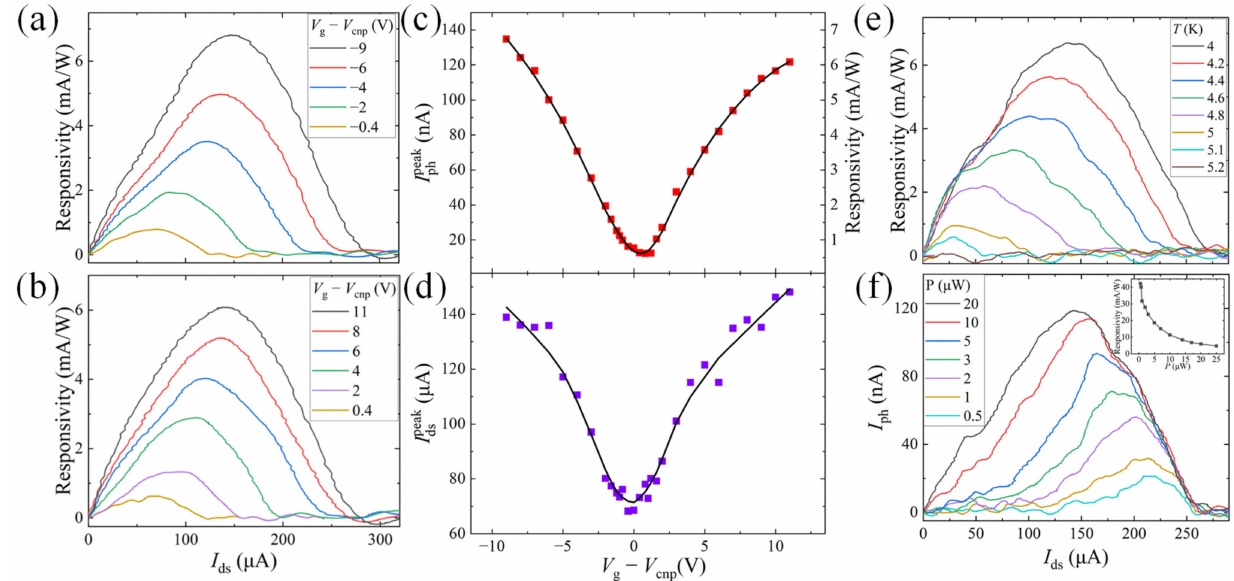
Figure 3. Modulation of the photoresponse in the superconducting NbSe 2 -MLG heterostructure. ( a , b ) Photoresponsivity as a function of the bias current at selected top gate voltages for p -doped ( a ) and n -doped graphene ( b ), respectively. The laser power is P = 20 µ W and the temperature is T = 4.0 K. ( c , d ) The maximum photocurrent I peak (red square dots in ( c )) and the peak position I peak ph ds (purple square dots in ( d )) extracted from ( a , b ) as a function of the top gate voltages, respectively. The black solid lines are added as a guide to the eye. ( e ) Photoresponsivity versus I ds at selected temperatures. The gate voltage and laser power are kept at V g − V cnp = − 9 V and P = 20 µ W. ( f ) Photocurrent I ph versus I ds at selected laser powers with V g − V cnp = − 9 V and T = 4.0 K. Inset: The maximum photoresponsivity (black square dots) extracted from ( f ) as a function of the laser power.